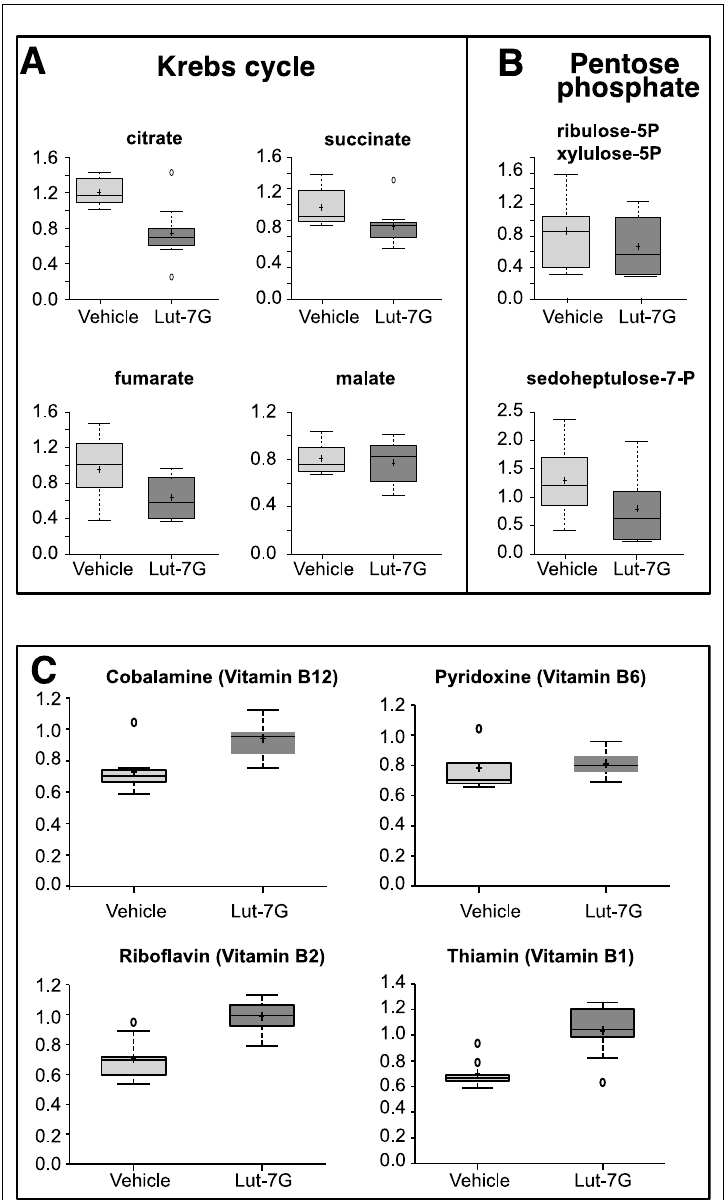
Figure 2. ( A ) Metabolomic analysis of tricarboxylic acid cycle or krebs cycle (TCA) intermediates showing the depression of citrate, succinate, fumarate, and malate in LUT-7G treated keratinocytes. ( B ) Analysis of intermediate of pentose phosphate pathway also shows a downregulation. ( C ) The analysis of important vitamin cofactors shows increased